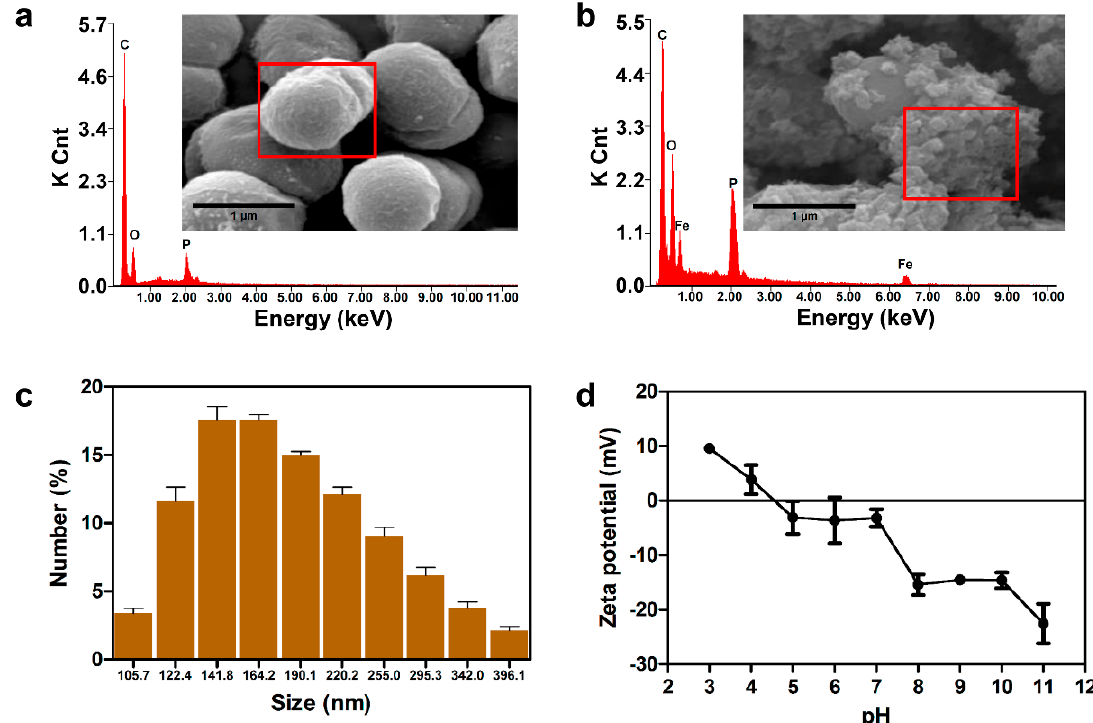
Figure 2. Scanning electron microscopy-energy dispersive X-ray spectroscopy (SEM-EDX) analysis of ( a ) D. radiodurans R1 and ( b ) iron nanoparticle immobilized D. radiodurans R1 (DR-FeNPs). Inset represents 50 kX magnified SEM images of D. radiodurans R1 without (left) or with (right) FeCl 3 ; ( c ) dynamic light scattering (DLS) analysis of FeNPs synthesized by D. radiodurans R1 in vivo; ( d ) zeta potential analysis of DR-FeNPs. All experiments were performed in triplicate; error bars denote standard deviation.